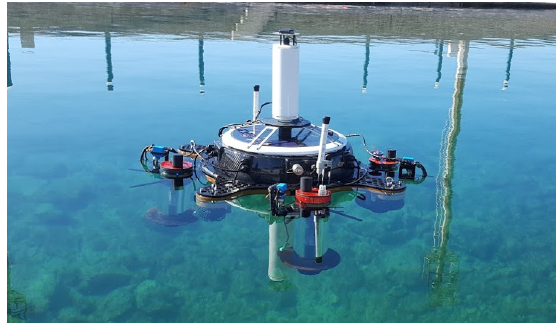
Figure 10. An aPad with four docked aMussels in a pool testbed.